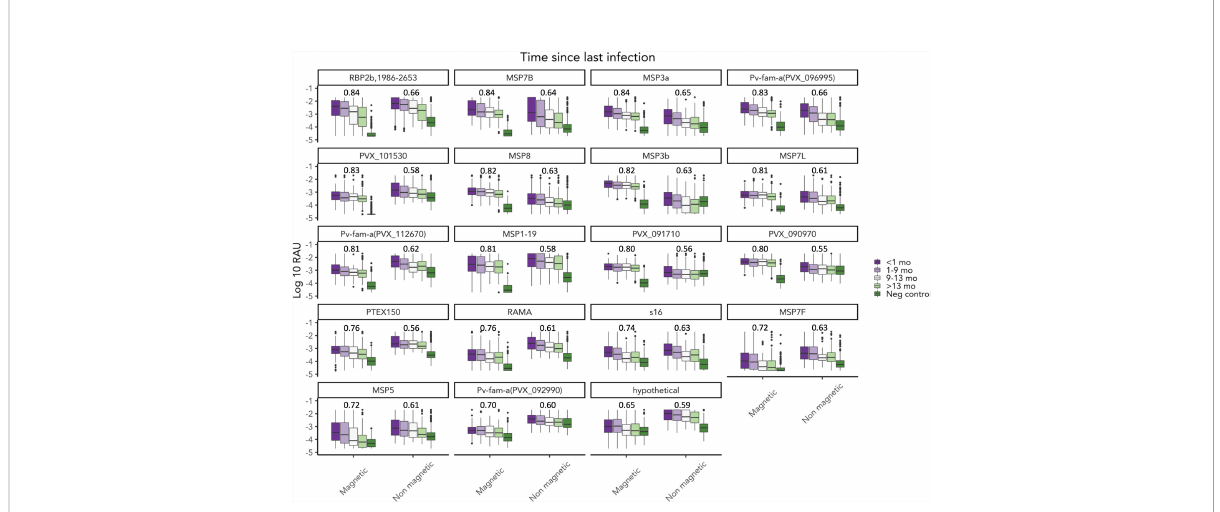
FIGURE 5 Comparison of total IgG measured using magnetic beads versus non-magnetic beads. Total IgG to 19 P. vivax antigens was measured using magnetic and non-magnetic beads in the multiplex assay. Total IgG was measured in the Peruvian cohort (n = 590) and negative controls (n = 274). AUC value was noted in the fi gure. Non-magnetic bead AUC value was obtained from a published paper by Rosado et